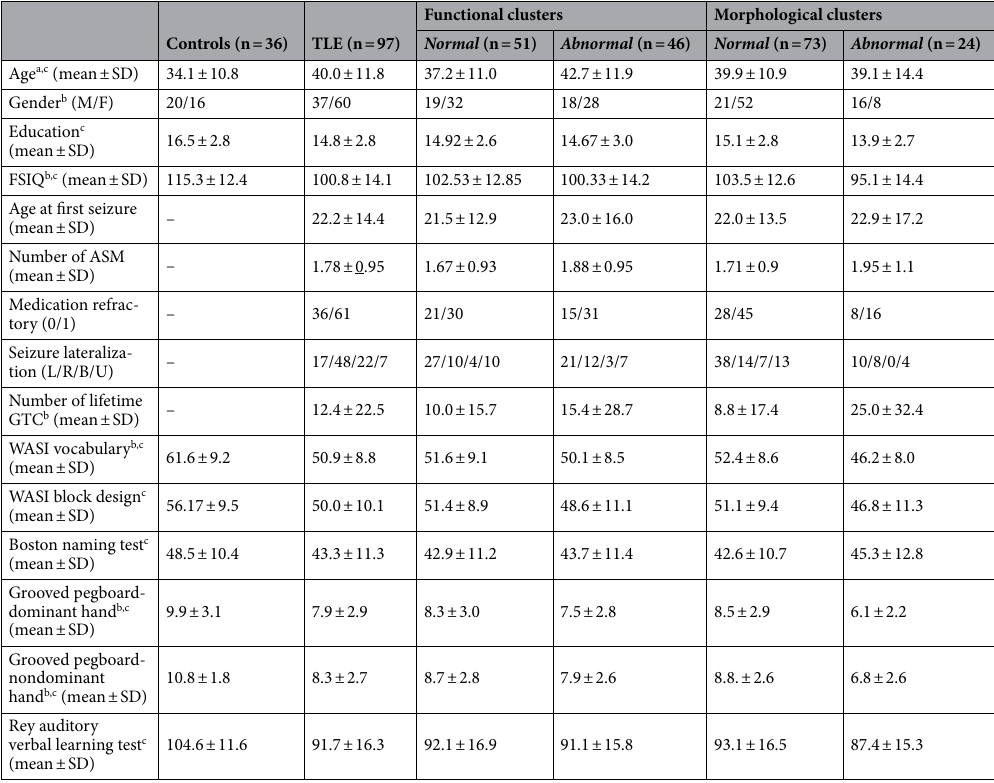
Table 1. Functional and morphological clusters. L left, R right, B bilateral, U unknown. a Significantly different between functional clusters. b Significantly different between morphological clusters. c Significantly different between controls and